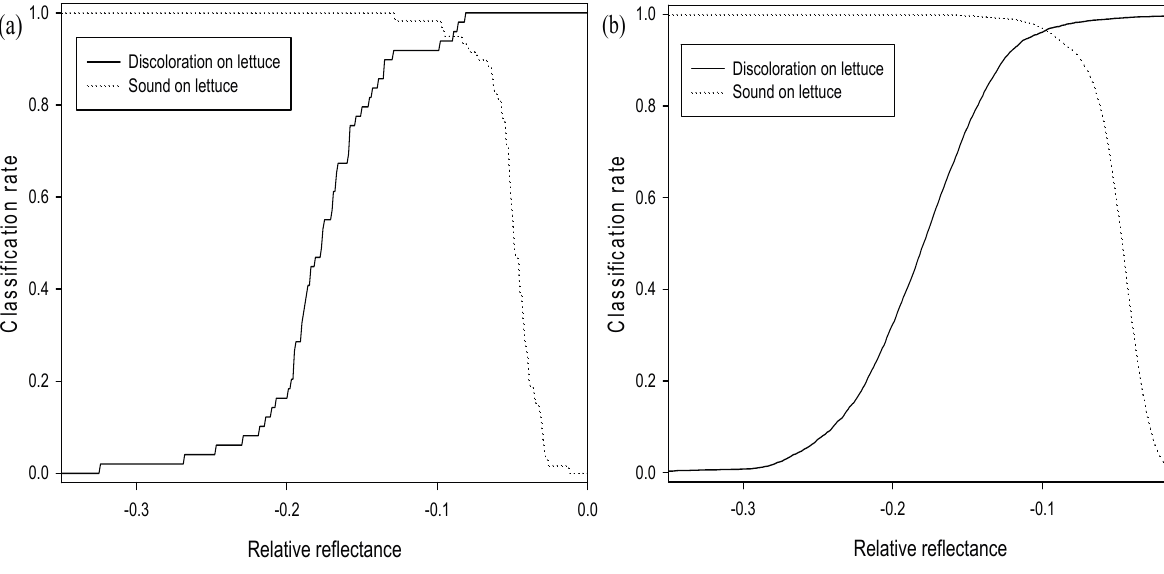
Figure 10. Classification rate results for the sound and discolored areas on both adaxial and abaxial surfaces using the subtraction of two wavebands (S 557-701 ): ( a ) average spectrum and ( b ) pixel